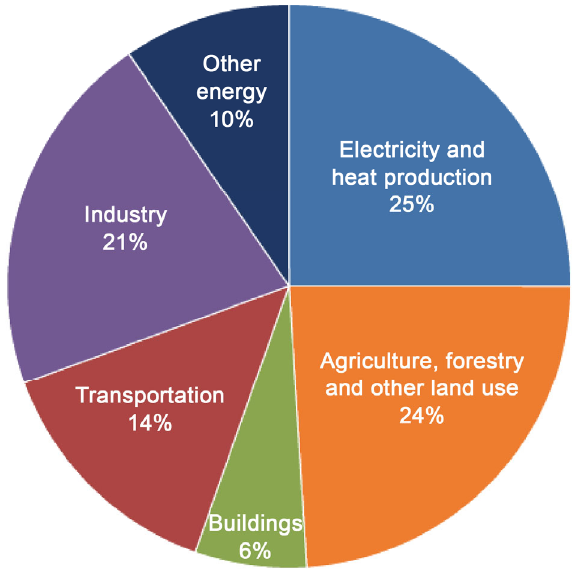
Fig. 8 Global greenhouse gas emissions by economic sector